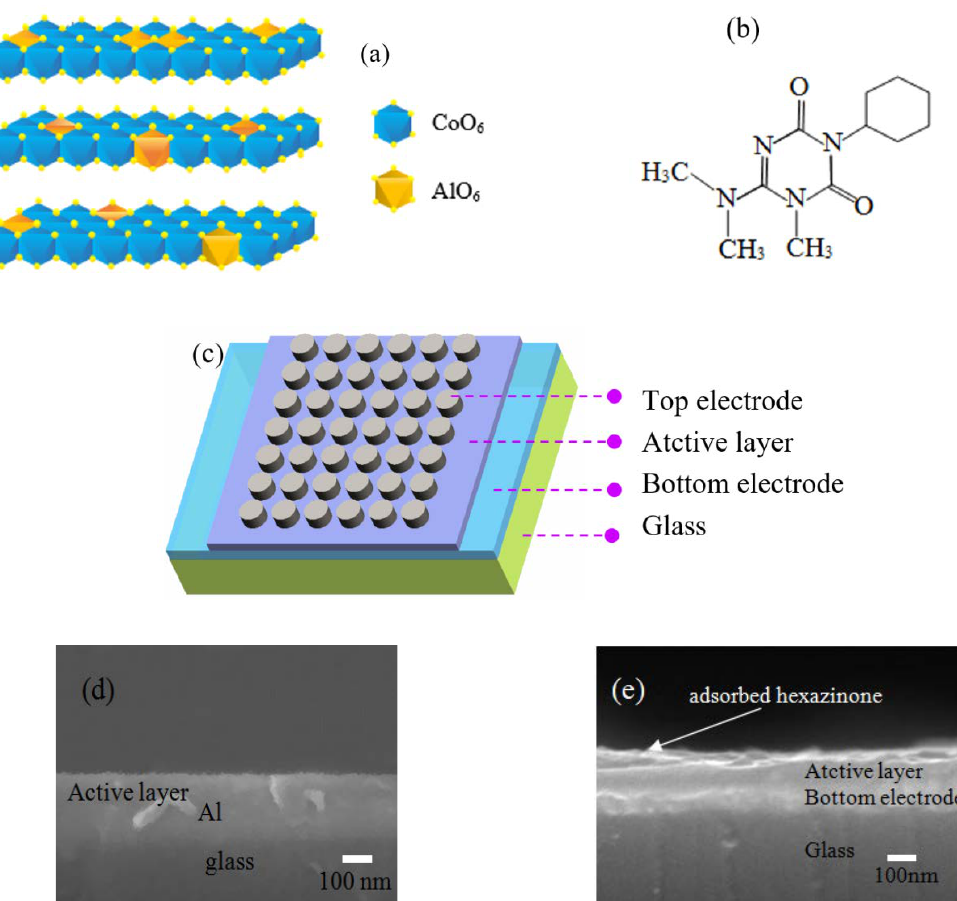
Figure 1. ( a ) Chemical structure diagram of Co–Al-layered double hydroxides (LDHs). ( b ) Chemical structure of hexazinone. ( c ) Schematic structure of the Co–Al LDHs-based memristor. ( d ) Cross section of the resistive switching layer for the Co–Al LDHs memristor. ( e ) Cross section of the resistive switching layer for the Co–Al LDH-adsorbed hexazinone memristor. − 1 Figure 2. In the FTIR spectrum of hexazinone, as shown in Figure 2a, the absorption band at 2975 cm − 1 corresponds to the stretching vibration of methyl C–H. Absorption bands centered at 2849 cm were caused by the stretching vibration of methylene C–H. Two adjacent bands centered at 1721 and 1635 cm − 1 were caused by the stretching vibration of 2-bit C=O and 1-bit C=O, respectively. On the other hand, absorption bands centered at 1554 cm − 1 are attributed to the C=N stretching vibration. Absorption bands centered at 1352 cm − 1 were caused by C–H deformation vibration of CH 3 O [39]. − 1 The broad strong absorption band centered at 3396 cm originated from the stretching vibrations − 1 of surface and interlayer hydroxyl groups [42], as shown in Figure 2b. The weaker band at 1648 cm − 1 came from the bending mode of water molecules. Bands centered at 589 cm were derived from the stretching and bending vibration of metallic oxygen (M-O) or metallic hydroxyl (M-OH) [43]. The FTIR spectrum of Co–Al LDHs after adsorption of hexazinone is shown in Figure 2c. In hexazinone adsorbed − 1 on Co–Al LDHs, two bands at 2975 and 2849 cm disappeared, and a new band of hexazinone − 1 appeared at 1349 cm , which indicates symmetric vibrations of